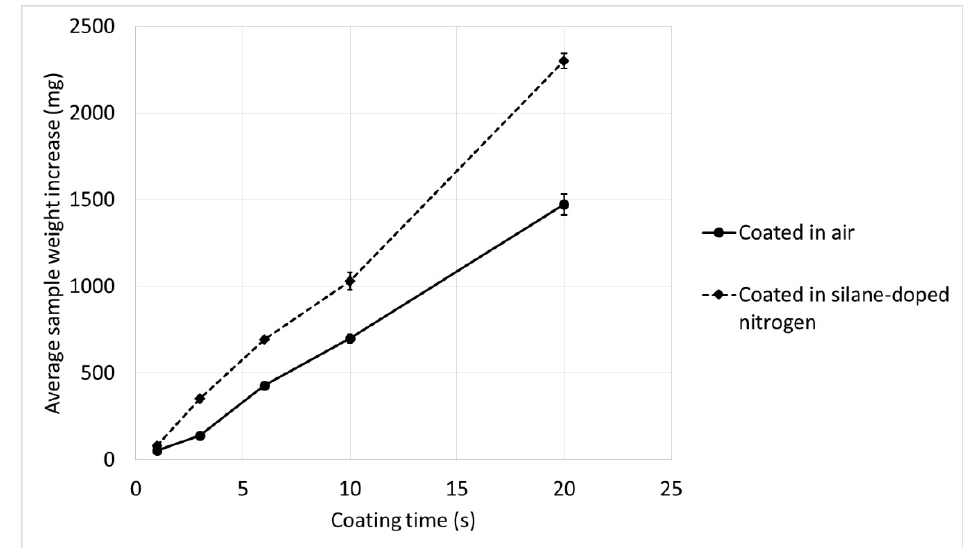
Figure 9. Average sample weight increase versus coating time in the application of wire arc sprayed copper coatings in different coating environments.